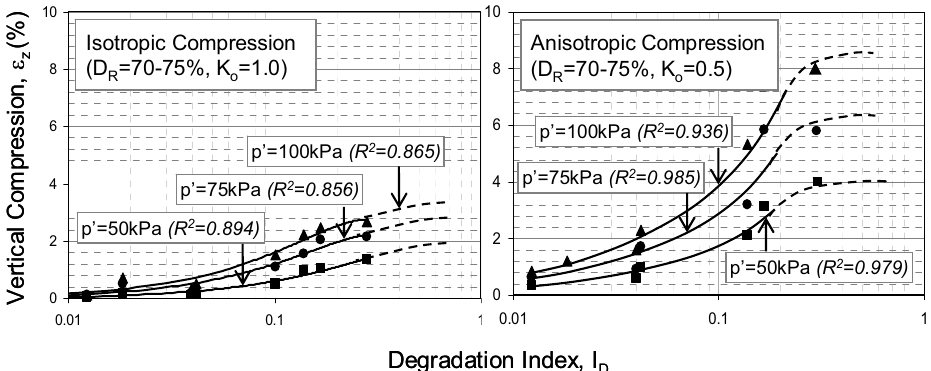
Fig. 11. I D - ε z relationships for K o =1.0 and 0.5 from consolidation data. Figure 11. I D - (cid:72) z relationships for K o =1.0 and 0.5 from consolidation data. 3